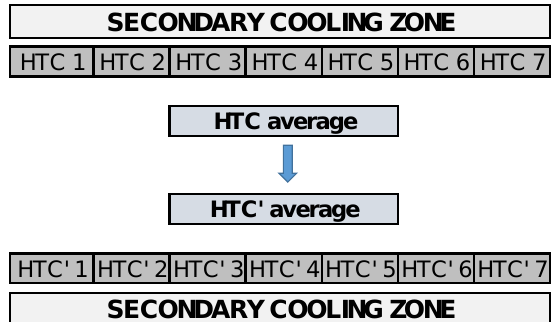
Figure 1. Models of heat transfer coefficient versus temperature on the strand surface (adopted from [3], with permission from Polish Academy of Science, 2018).